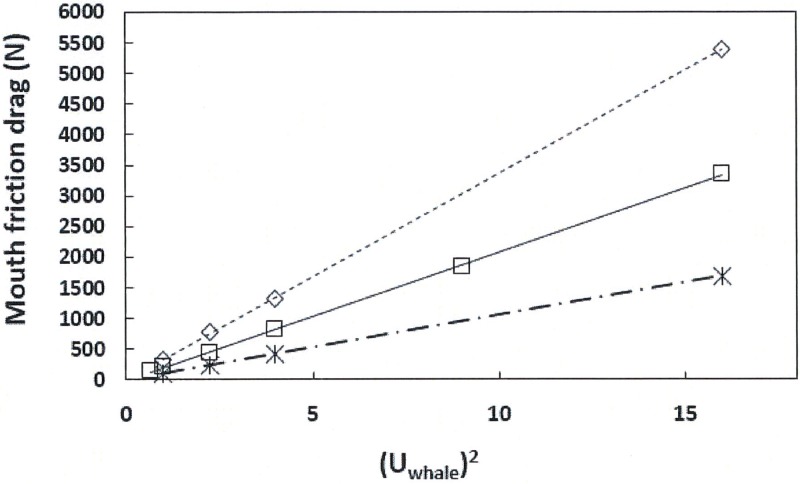
Mouth friction drag versus the square of the swim speed and mouth inlet parameters (Din).Calculated for 10m body length via Eq 3. Here dbaleen = 0.01m, cbaleen = 0.07m, hHT = 1.5m, and C = 0.44 (“with prey” [9]). The mouth inlet widths considered were Din = 0.30m (starburst and dash-dot line), Din = 0.50m (squares and continuous line) and Din = 0.72m (diamonds and dotted line) respectively. The slopes corresponding to the lines are as follows: 105.57 kg/m (8m; R2 = 0.99), 207.95 kg/m (10m; R2 = 0.99), 337.04 kg/m (15m-case B; R2 = 0.99) and 431.98 kg/m (15m-case A; R2 = 0.99). As with Fig 9, the presence of the straight lines in this plot suggest a swim speed-independent but Din-dependent drag coefficient for the drag generated by the internal flows of the oral apparatus (see Eq 6b).